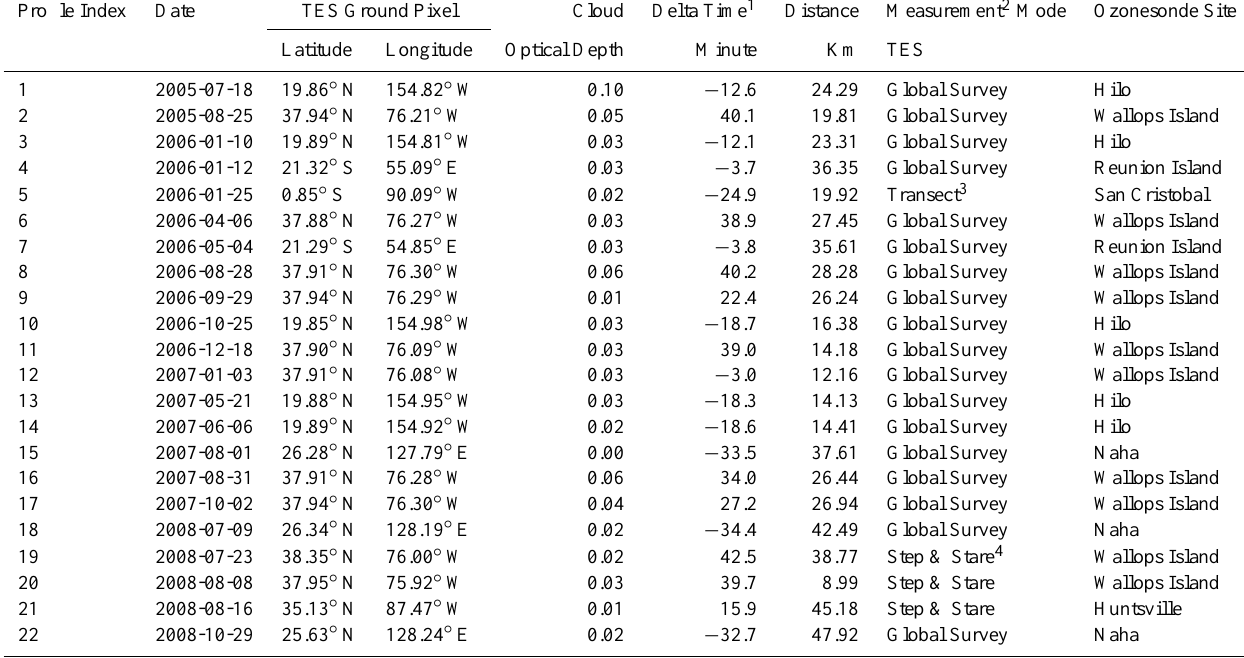
Table 2. Coincident measurements among TES, OMI, and